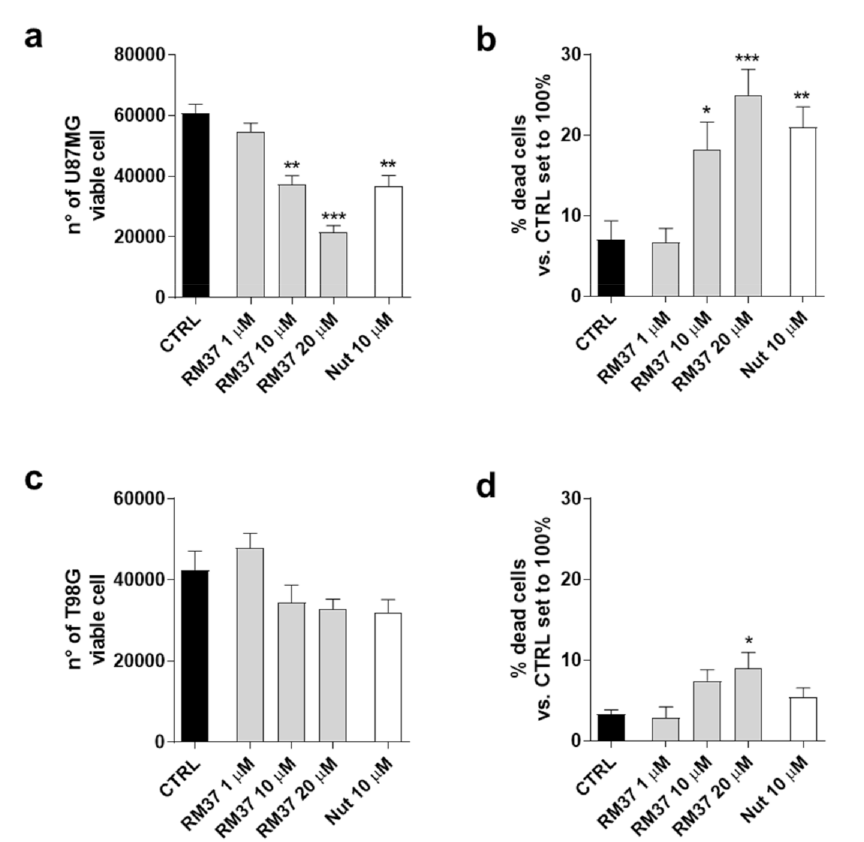
Figure 8. Effects of RM37 on different glioblastoma cells. ( a ) U87MG live cells; ( b ) U87MG dead cells; ( c ) T98G live cells; ( d ) T98G dead cells following treatment with different concentrations of RM37 (1–20 µ M) for 48h. Data are mean values ± SEM of three different experiments. * p < 0.05; ** p < 0.01; *** p < 0.001 versus